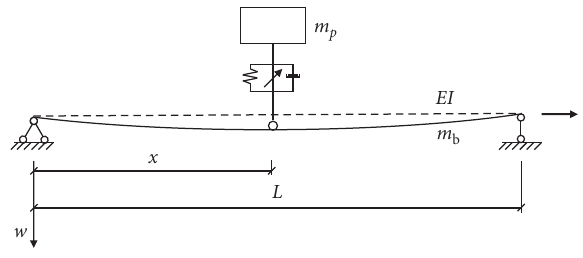
Figure 14: Schematic view of the human-structure interaction